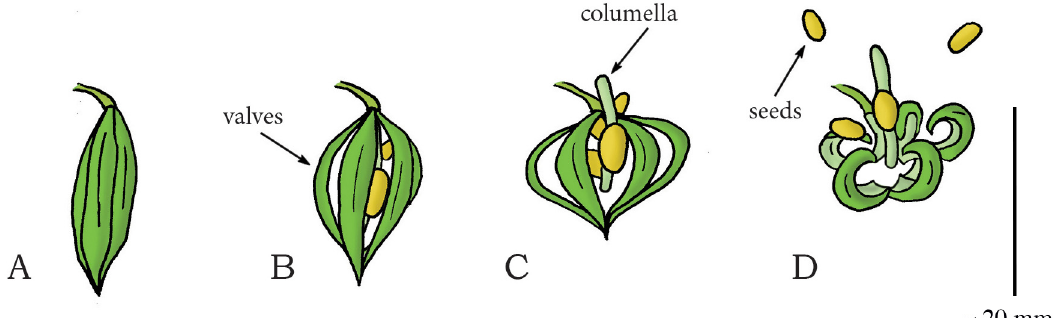
Fig 11. Swelling coiling catapult mechanism in Impatiens capensis . (A) The seedpod consisting of five interconnected valves. Elastic energy is stored in the seedpod by the absorption of water in the valves. When a critical pressure is reached, dehiscence of the valves from the columella and subsequent coiling discharges the seeds (A – D). (A) Shows the situation at t = 0 ms. Duration from (A) to (D) lasts about 3 to 4 ms. Drawings based on schematic drawings in [69]. Scale bar 20